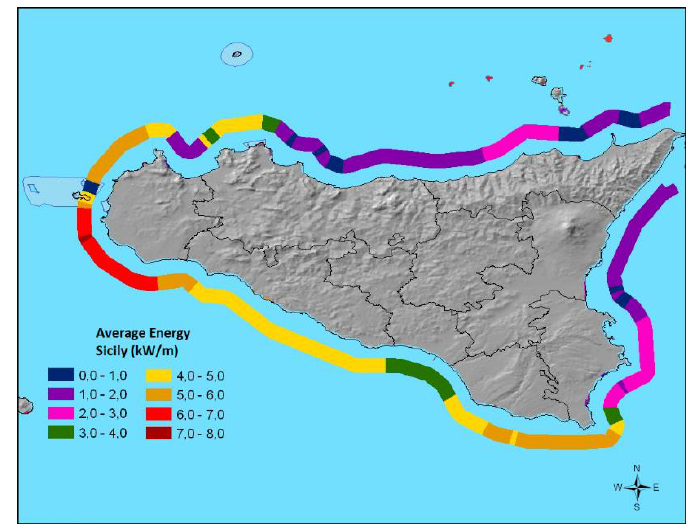
Figure 4. Average power (measured in kW/m) in the along the Sicilian coastlines [22].